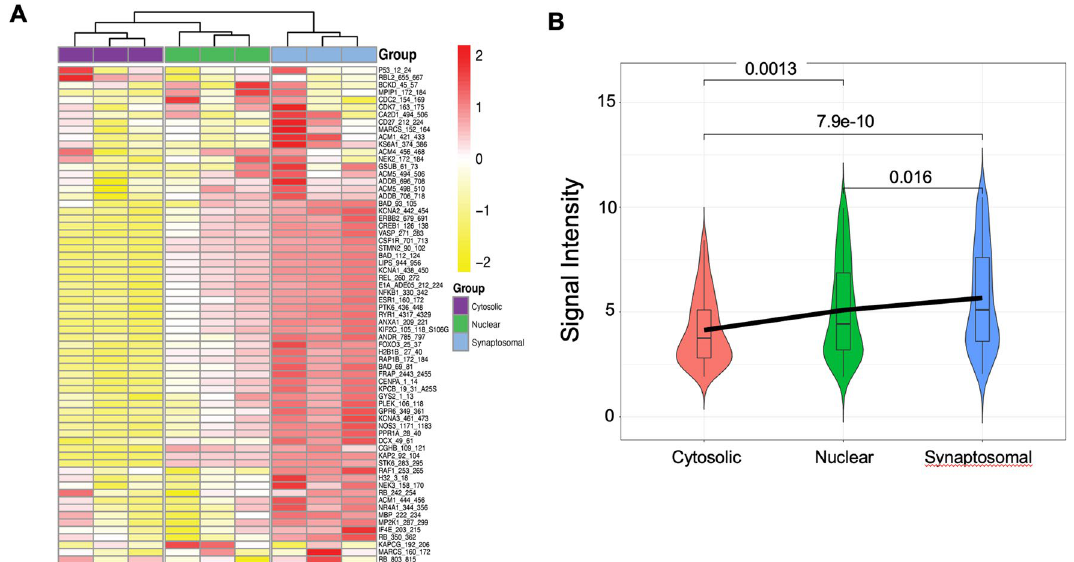
Figure 2. Global Phosphorylation Signals Show Distinct Patterns for Cytosolic, Nuclear and Synaptosomal Fractions. ( A ) Unsupervised hierarchical clustering of the endpoint signal intensity for all of the STK PamChp4 reporter peptides that passed quality control. The values are normalized by peptide (Z-transformed) to highlight the differences between the samples. ( B ) Violin Plots showing the mean global intensity for each group. Statistical comparisons were performed using Wilcoxon’s rank sum test for nuclear vs cytosolic ( p < 0.001), synaptosomal vs cytosolic ( p < 0.001) and synaptosomal vs nuclear p = 0.016) fractions. The heatmaps and violin plots were generated using KRSA package (v0.10.3—https:// github. com/ CogDi sResL ab/ KRSA) using R version